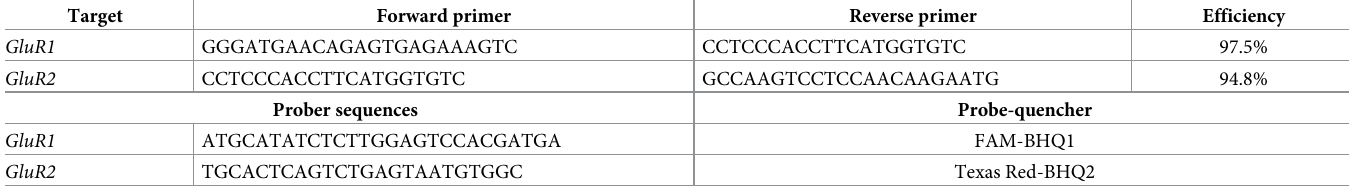
Table 2. Primer sequences for Probe-based qPCR assays.